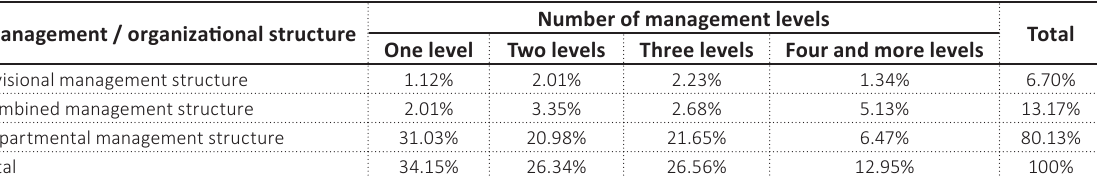
Table 4. Dependence between management structure and the number of management levels in the enterprises